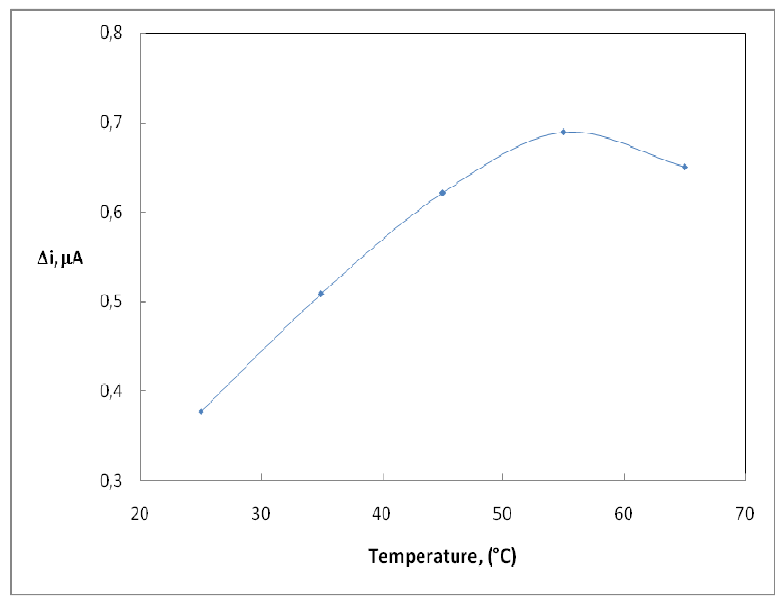
Figure 3 . The effect of temperature upon the sensitivity of biosensor against 4.0×0.10 -5 M uric acid (0.05 M, pH 9.0 borate